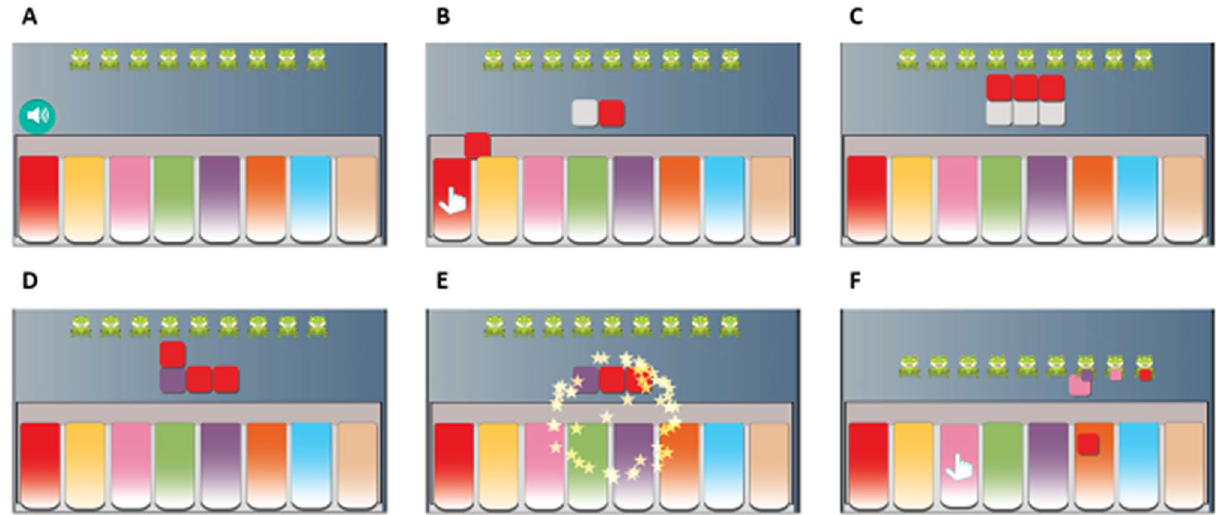
Figure 3. Piano Game gameplay. ( A ) The player clicks on the speaker icon to make the computer play a target sequence. ( B ) When the target sequence is played, tiles of the same colors as the played keys are generated and aligned above the keyboard. In addition, a visual cue (hand) indicates the pressed keys. After a delay, the colors of the tiles are hidden (color turns to white). Now, the player is prompted to repeat the target sequence using the keyboard. ( C ) As the player presses the keys, tiles corresponding to the pressed keys are arranged on top of the tiles of the target sequence. ( D ) When the player finishes repeating the sequence, the colors of the target tiles are uncovered, and the matches between the target and the player’s tiles are displayed. ( E ) An audio-visual reinforcement is provided if there is a complete match, and the play starts again with subsequent notes from the same song. The correctly played tiles also get added to a sequence of frogs at the top part of the screen. ( F ) At the end of a level, when the user has completed multiple sequences of a given length, the full song is played with animation. The user then progresses to the next level with longer